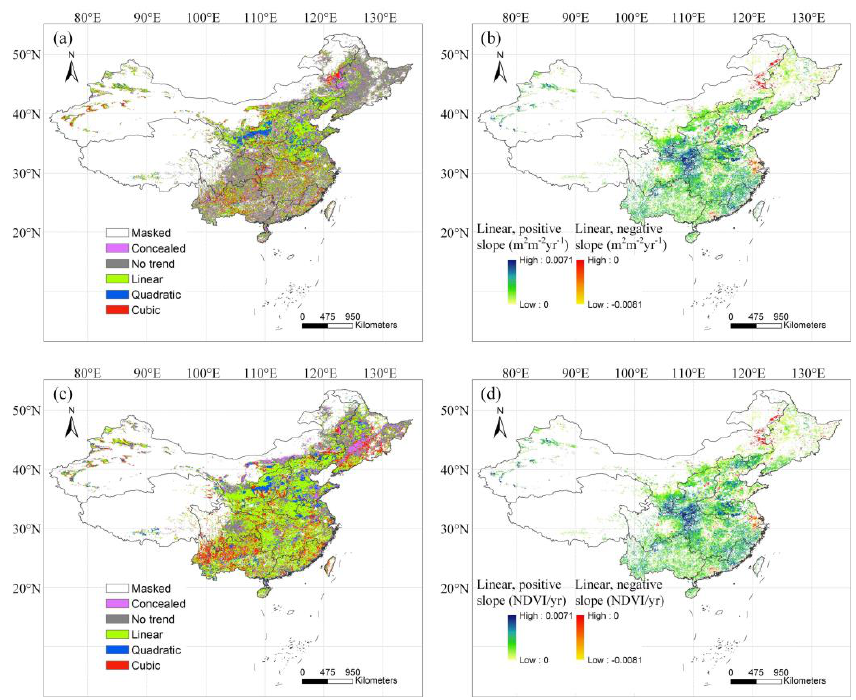
Figure 4. Greenness trends derived by the PolyTrend algorithm from 1982 to 2015 in Chinese croplands: trend classification maps based on ( a ) GLASS LAI and ( c ) GLASS NDVI; and linear trends of annual ( b ) GLASS LAI and ( d ) GLASS NDVI detected by PolyTrend. Land 2020 , 9 , x FOR PEER REVIEW